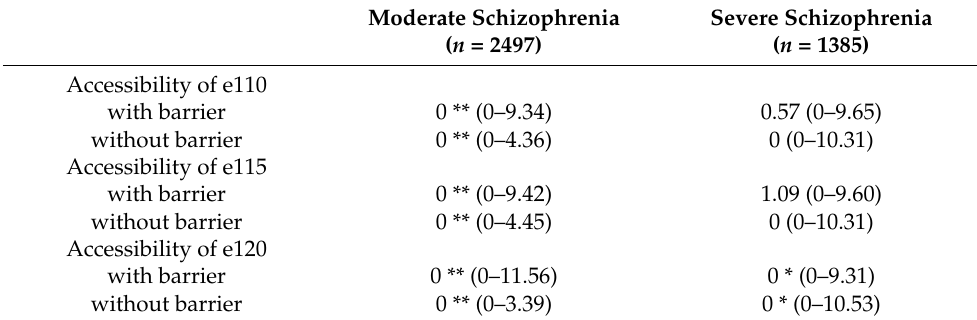
Figure 2. ROC curves used to classify patients with schizophrenia with and without accessibility barriers in the categories of chapter e1 products and technology by utilizing the summary index scores of their performance. Results for patients with moderate schizophrenia ( n = 2497) are presented in the top row, while results for patients with severe schizophrenia ( n = 1385) are found in the bottom row. Column ( a ) shows results for category e110 for personal consumption, column ( b ) shows results for category e115 for personal usage in activities of daily living, and column ( c ) shows results for category e120 for personal outdoor and indoor mobility and transportation. Table 4. Comparison of relative difference (RD, capacity-performance discrepancy) of the summary index (SI) between schizophrenia patients with and without accessibility barriers to the categories in chapter e1 products and technology, including environmental categories e110 for personal con- sumption, e115 for personal usage in activities of daily living, and e120 for personal outdoor and indoor mobility and transportation, stratified for patients with moderate schizophrenia ( n = 174 in accessibility of e110 with barrier, n = 215 in accessibility of e115 with barrier, n = 319 in accessibility of e120 with barrier) and severe schizophrenia ( n = 170 in accessibility of e110 with barrier, n = 203 in accessibility of e115 with barrier, n = 285 in accessibility of e120 with